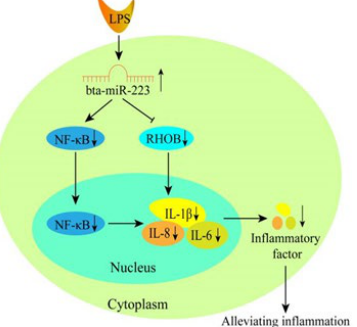
Figure 7. Summary of the mechanism of action of bta-miR-223 in bMEC inflammation. In the LPS- stimulated bMEC response, high expression of bta-miR-223 suppresses the expression of its target genes, RHOB and NF - κB at the protein level, ultimately leading to inhibition of the inflammatory factors IL- 1β, IL -8 and IL-6 at the transcriptional and translational levels, thereby alleviating the inflammatory response in bMECs.